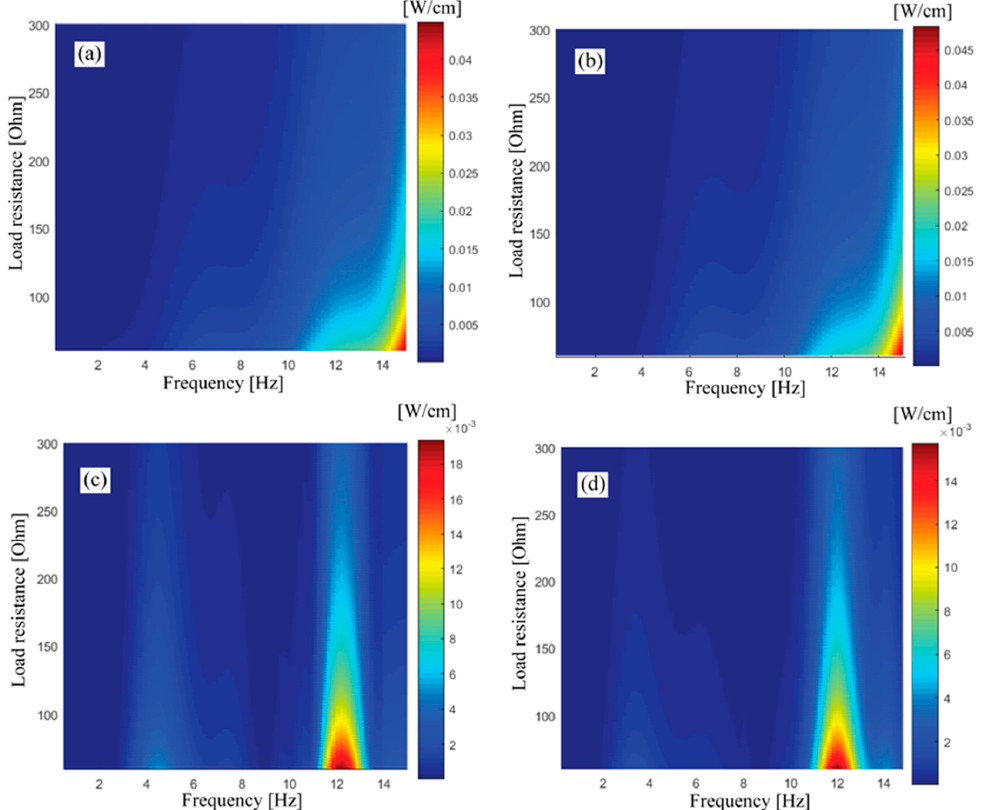
Figure 9. Power density for an electrical load resistance 0-300 Ohms. ( a ) Inductive mode for the beam of 9 cm. ( b ) Magnets to 125° with a beam of 9 cm. ( c ) Magnets to 110° with a beam of 15 cm. ( d ) Magnets to 95° with a beam of 21 cm.